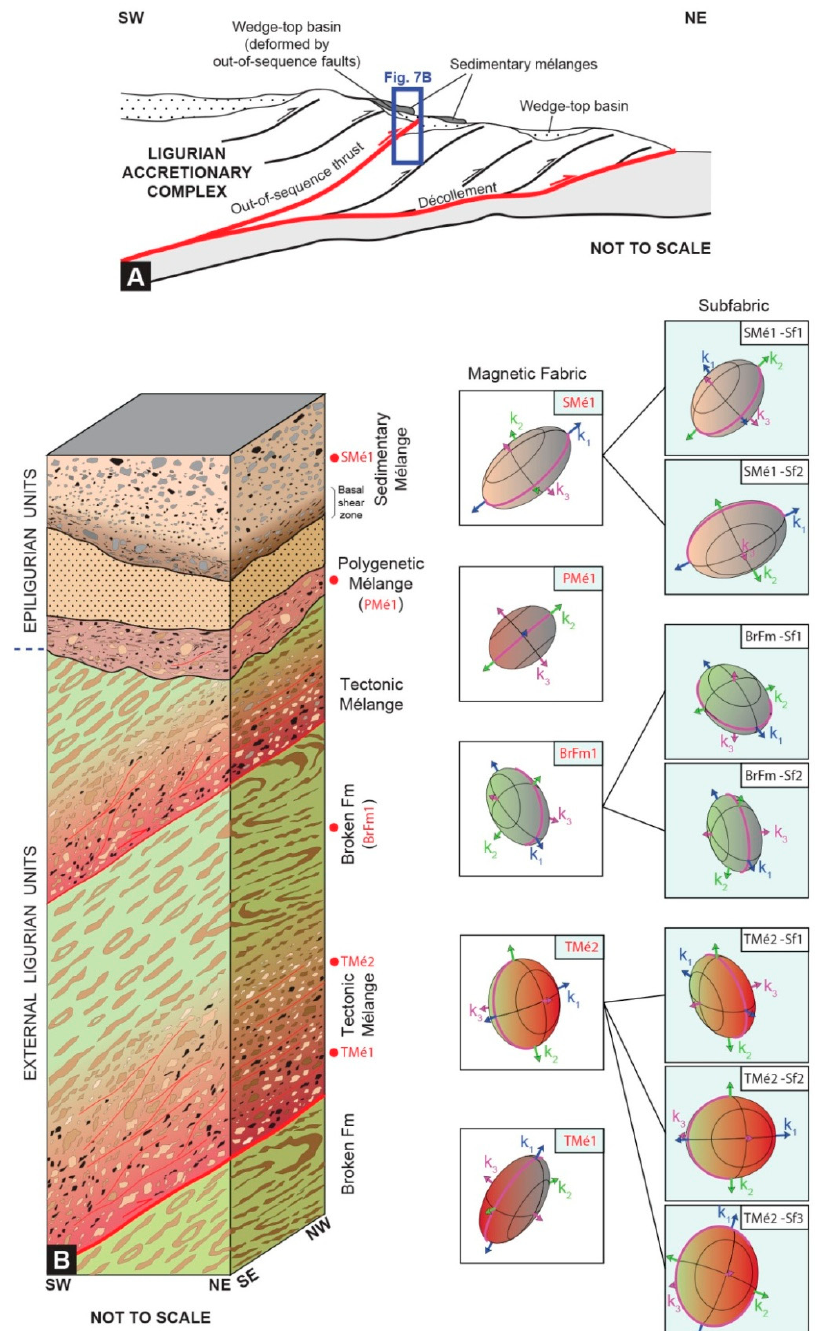
Figure 7. ( A ) Conceptual cross-section (not to scale) of the Ligurian accretionary complex (modified from [87]), the blue box represents the schematic 3D stratigraphic column of Figure 7B; ( B ) conceptual 3D stratigraphic column (not to scale) showing the internal arrangement and structural position of the di ff erent types of m é lange (tectonic, sedimentary, and polygenetic) and broken formation and related AMS ellipsoids oriented to present-day geographic coordinates (see text for explanation). Red and black lines in the 3D stratigraphic column represent tectonic and stratigraphic contacts,